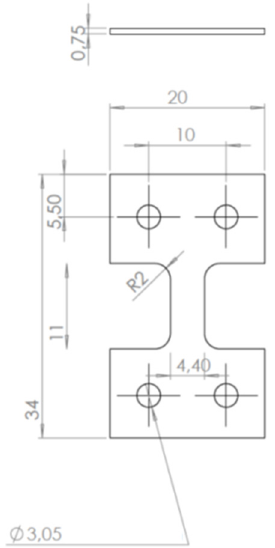
Figure 4. In situ tensile test specimen geometry.